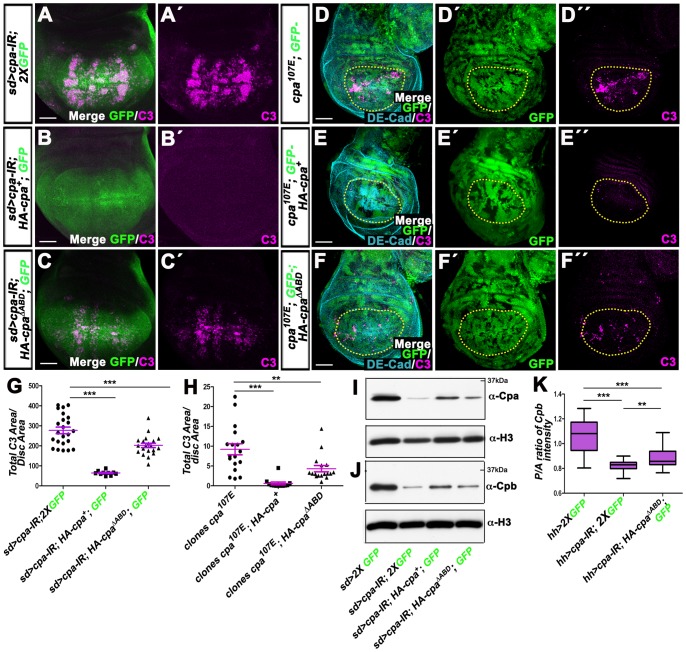
Expressing HA-cpa or HA-cpaΔABD suppresses apoptosis and restores Cpb levels of wing discs knocked-down for cpa.(A–A′ to F–F′) standard confocal sections of third instar wing imaginal discs with dorsal sides up. (A–A′ to C–C′) sd-Gal4 driving (A–A′) UAS-cpa-IRC10 and two copies of UAS-mCD8-GFP (green in A) or (B–B′) UAS-cpa-IRC10, UAS-HA-cpa89E and one copy of UAS-mCD8-GFP (green in B) or (C–C′) UAS-cpa-IRC10, UAS-HA-cpaΔABD and one copy of UAS-mCD8-GFP (green in C). (D–D″ to F–F″) T155-Gal4; UAS-flp induced cpa107E mutant clones marked by the absence of GFP (green) and expressing (E–E″) UAS-HA-cpa89E or (F–F″) UAS-HA-cpaΔABD in the whole wing disc epithelium. Discs are stained with anti-activated-Caspase 3 (magenta), which monitors DRONC activation and (D–D″ to F–F″) anti-DE-Cad (cyan blue). The scale bars represent 30 µm. (G) quantification of total C3 area per disc area for the three genotypes shown in A–A′ to C–C′. The mean for sd>cpa-IRC10, 2XGFP is 92.4 (n = 23); for sd>cpa-IRC10, HA-cpa89E, 1XGFP is 0.7 (n = 10); for sd>cpa-IRC10, HA-cpaΔABD, 1XGFP is 51.4 (n = 20). Error bars indicate s.e.m. P<0.0001 for comparison of lane 1 and 2. P<0.0005 for comparison of lane 1 and 3. (H) quantification of total C3 area per disc area for the three genotypes shown in D–D″ to F–F″. The means for T155>flp; cpa107E is 9.228 (n = 18); for T155>flp; cpa107E; UAS-HA-cpa89E is 0.608 (n = 12); for T155>flp; cpa107E; UAS-HA-cpaΔABD is 4.329 (n = 17). Error bars indicate s.e.m. P<0.0001 for comparison of T155>flp; cpa107E and T155>flp; cpa107E; UAS-HA-cpa89E and P<0.0048 for comparison of T155>flp; cpa107E and T155>flp; cpa107E; UAS-HA-cpaΔABD. (I and J) western blots on protein extracts from wing discs expressing two copies of UAS-mCD8-GFP (lane 1) or UAS-cpa-IRC10 and two copies of UAS-mCD8-GFP (lane 2) or UAS-cpa-IRC10 and UAS-HA-cpa89E and one copy of UAS-mCD8-GFP (lane 3) or UAS-cpa-IRC10 and UAS-HA-cpaΔABD and one copy of UAS-mCD8-GFP (lane 4) under sd-Gal4 control, blotted with (I) anti-Cpa (upper panel) and anti-H3 (lower panel) or (J) anti-Cpb (upper panel) and anti-H3 (lower panel). (K) mean intensity of the ratio of Cpb intensity signals between posterior and anterior wing compartments of hh-Gal4 driving two copies of UAS-mCD8-GFP (lane 1) or UAS-cpa-IRC10 and two copies of UAS-mCD8-GFP (lane 2) or UAS-cpa-IRC10 and UAS-HA-cpaΔABD and one copy of UAS-mCD8-GFP (lane 3). The mean for lane 1 is 1.064 (n = 20), for lane 2 is 0.822 (n = 17), for lane 3 is 0.883 (n = 24). Error bars indicate s.e.m.. P<0.0001 for comparison of lanes 1 and 2 or 3 or P<0.0085 for comparison of lanes 2 and 3.